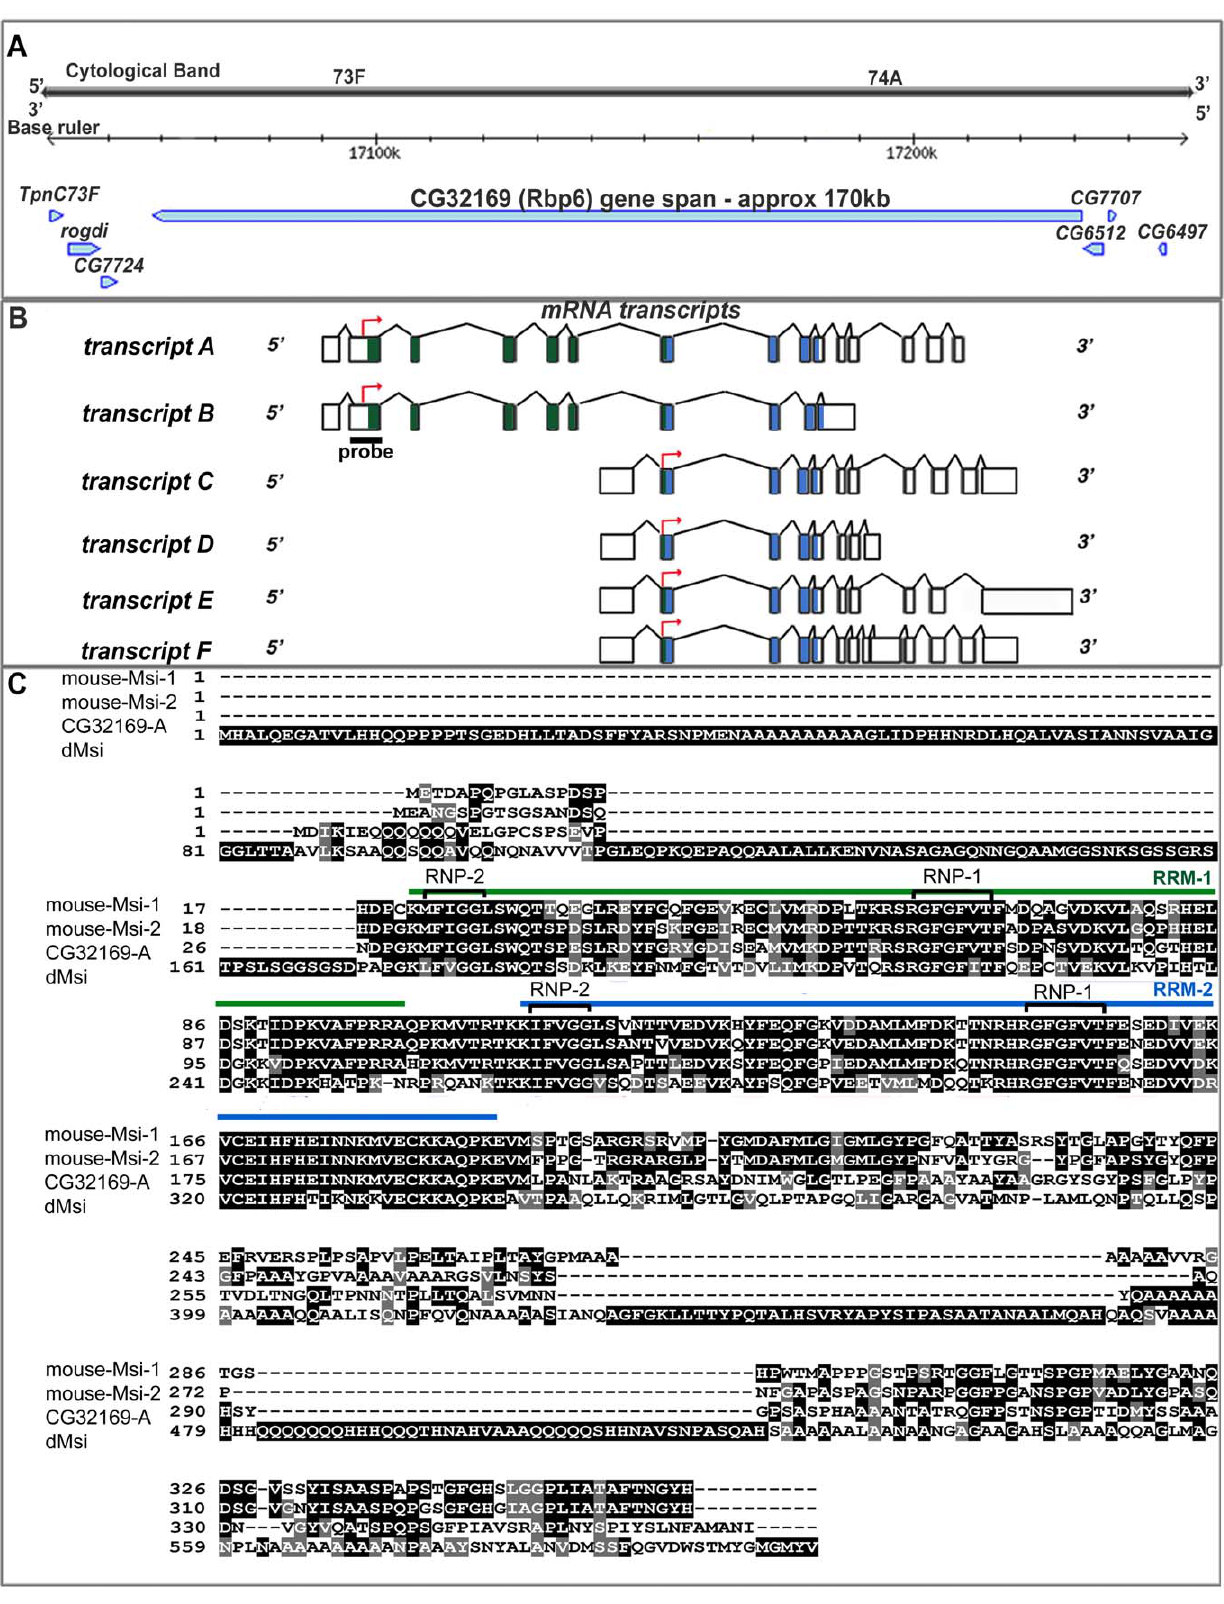
Figure 1. CG32169, also known as Rbp6, is a paralogue of dMsi and an orthologue of mammalian Msi proteins. (A) Genomic representation of CG32169 (Rbp6) on chromosome 3L (modified from Flybase). (B) CG32169 (Rbp6) has six transcripts. Exons encoding for RRM1 and RRM2 are coloured green and blue respectively, and coding start sites are indicated (red arrow). The region to which the RNA probe was designed is